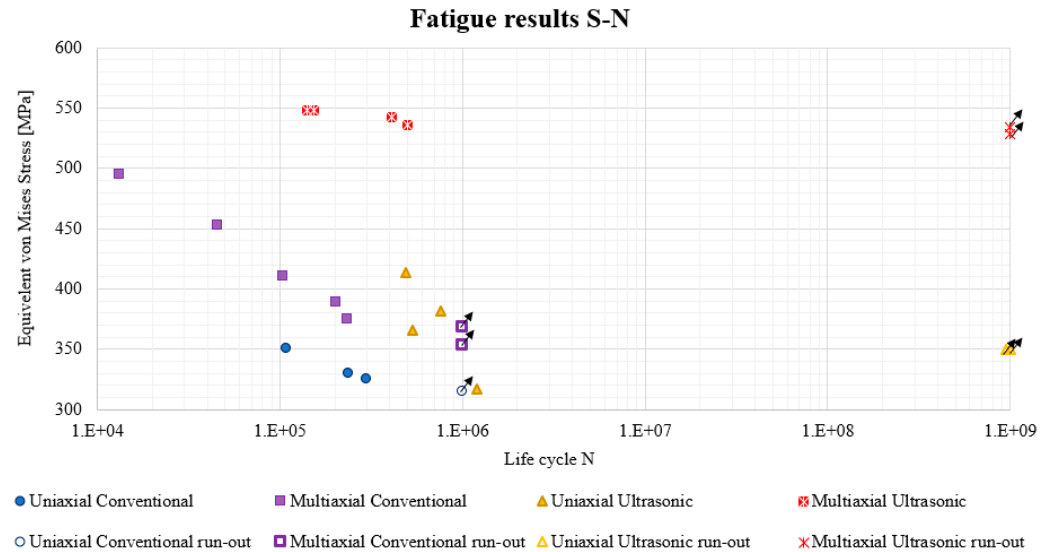
Figure 23. UFT tension / torsion stress life results.